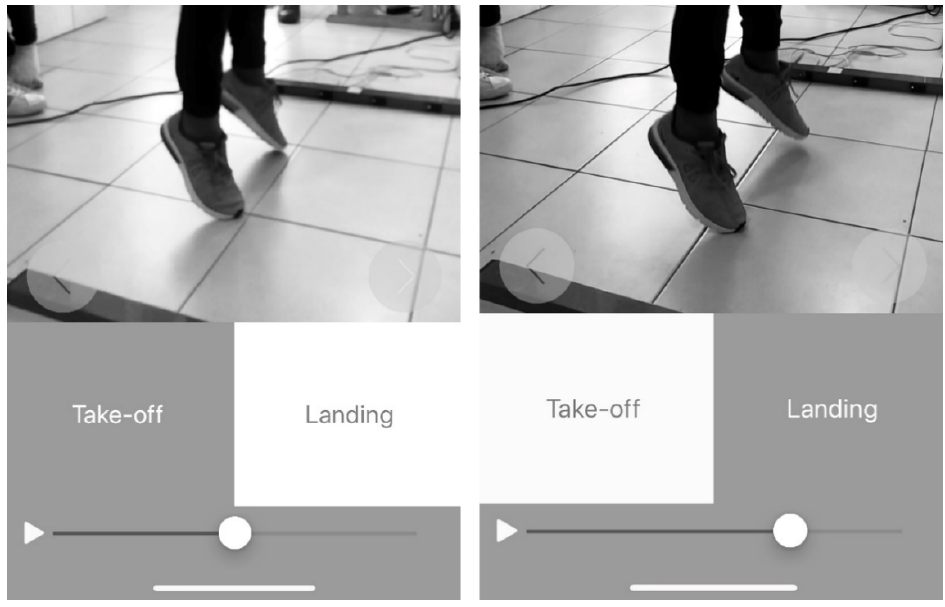
Figure 1. Take-off and landing phase frames on My Jump 2 app. Figure 1. Take-o ff and landing phase frames on My Jump 2